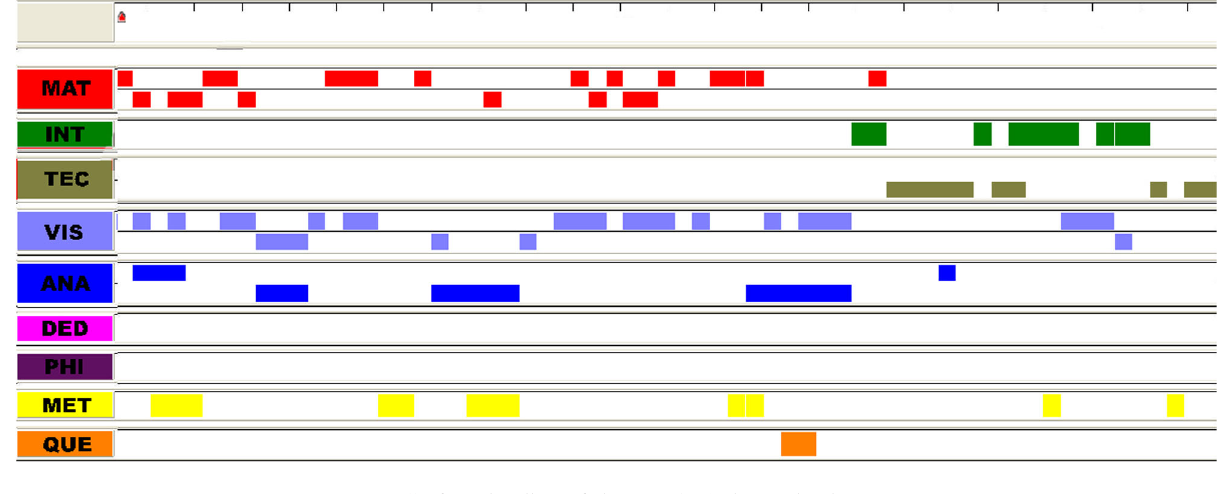
episode.FIG. 6. Timeline of the Ampère ’ s law